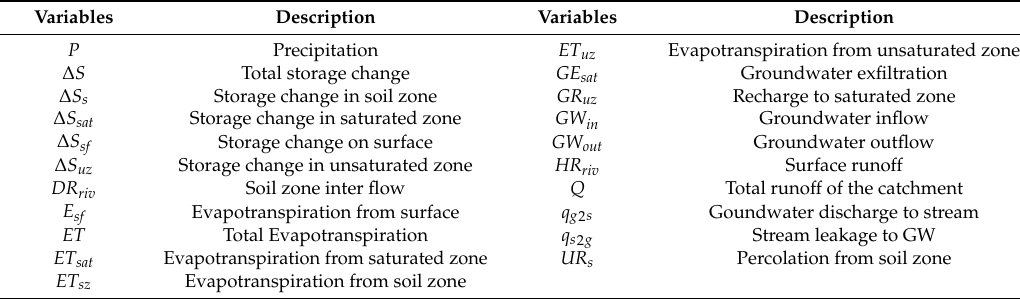
Figure 6. Schematic diagram of the water balance of the Miho catchment, averaged over 2005–2014. Table 2. List of symbols used in the schematic diagram in Figure 6.